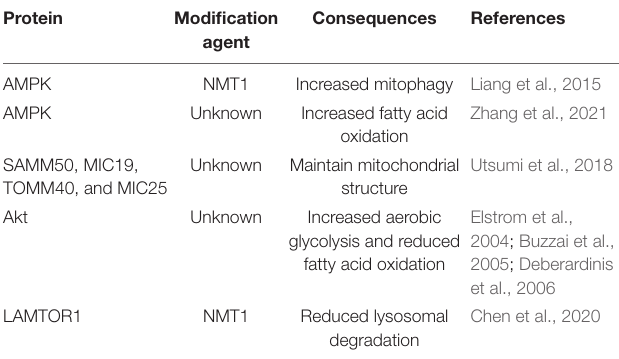
TABLE 2 | Summary of myristoylation involvement in cancer